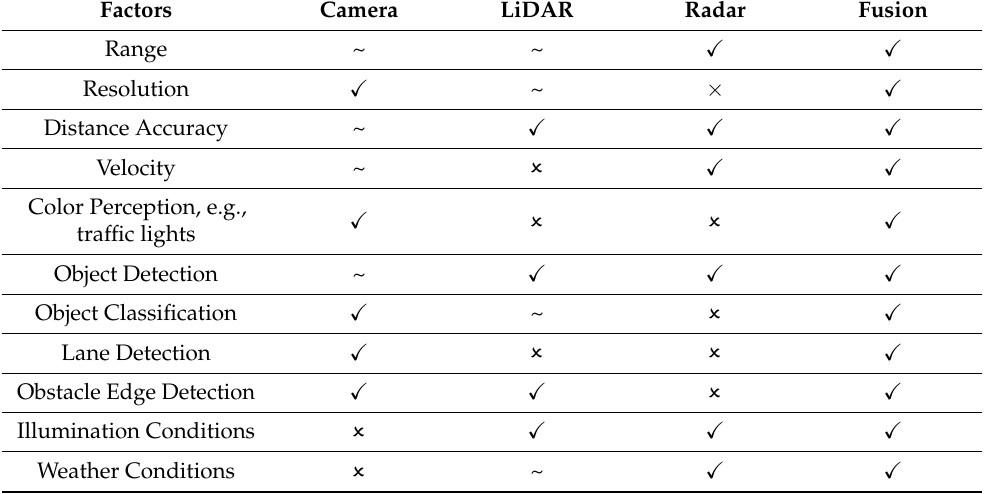
Checkerboard triangular pattern with trihedral corner retrore- -